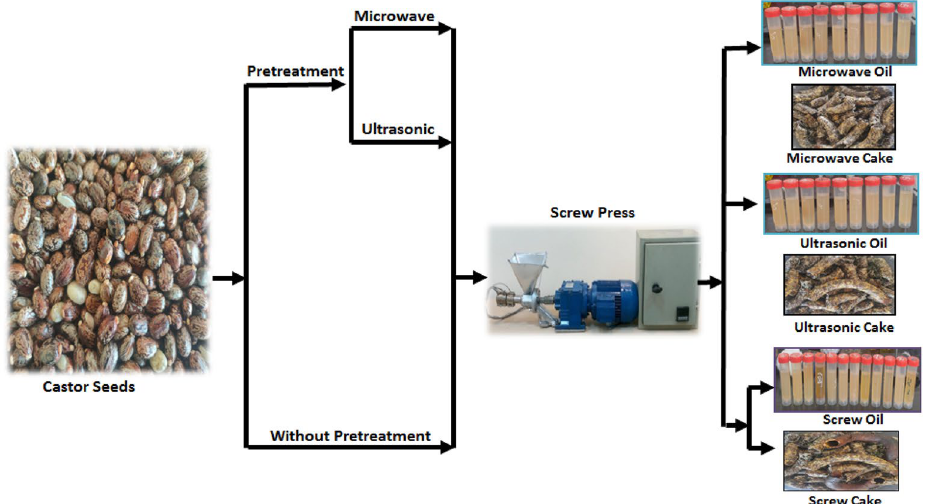
Figure 1. Schematic diagram of oil extraction by screw press from Egyptian castor